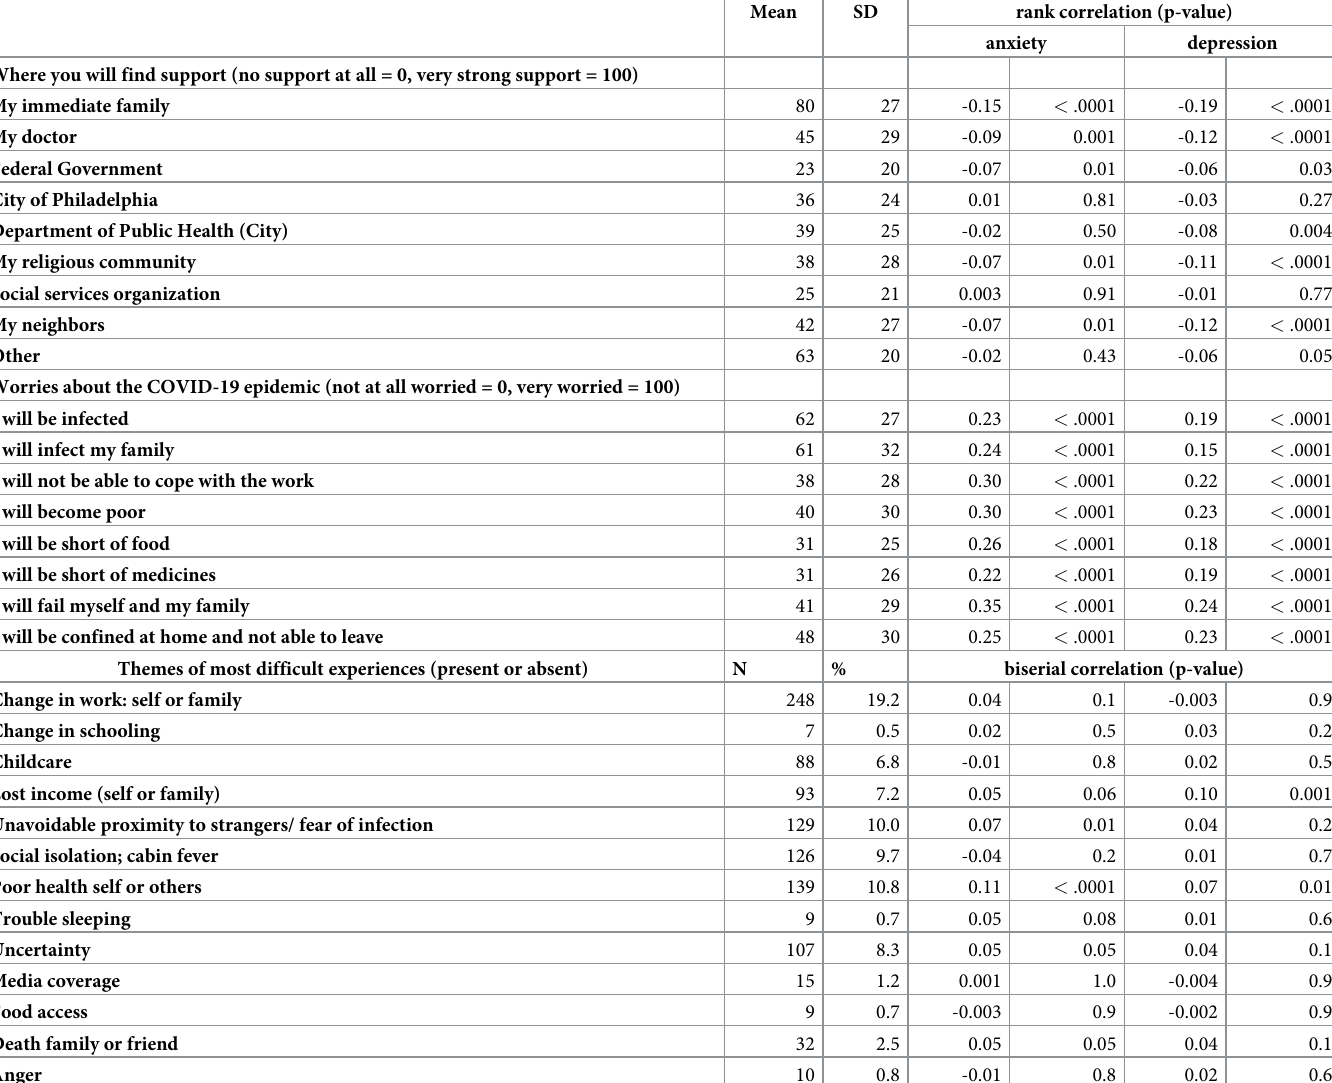
Table 2. Perceived sources of support, worries about the epidemic, and themes of reported most difficult experiences in relation to Hospital Anxiety and Depres- sion Scale scores among 1,293 participants in survey of adult residents of Philadelphia, PA, during the first wave of COVID-19 epidemic; means and standard devia- tions (SD) of support and worry scores are shown, as well as frequency (in %) of reported themes of most difficult